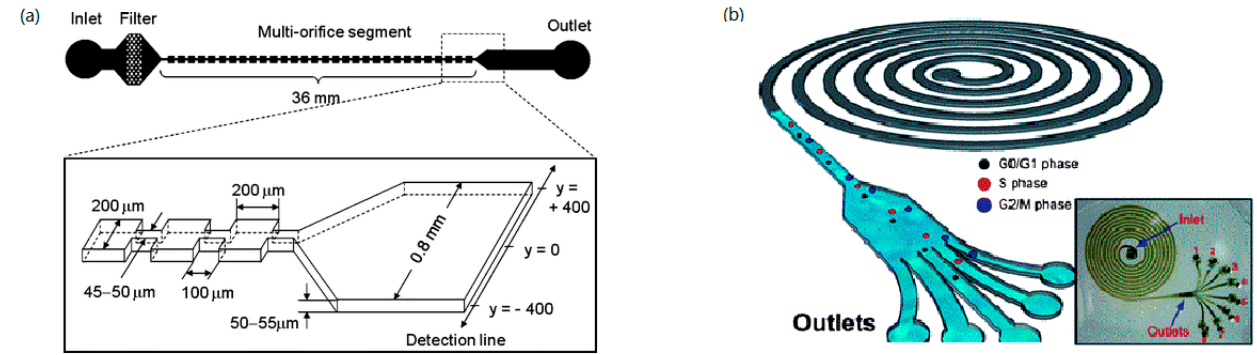
Figure 2. ( a ) Schematic diagram of multiorifice flow fractionation (MOFF) device. The figure has been reproduced with permission from the American Chemical Society [76]. ( b ) Schematic illustration of the spiral microfluidic design developed for cell-cycle synchronization. The figure has been reproduced with permission from the Royal Society of Chemistry